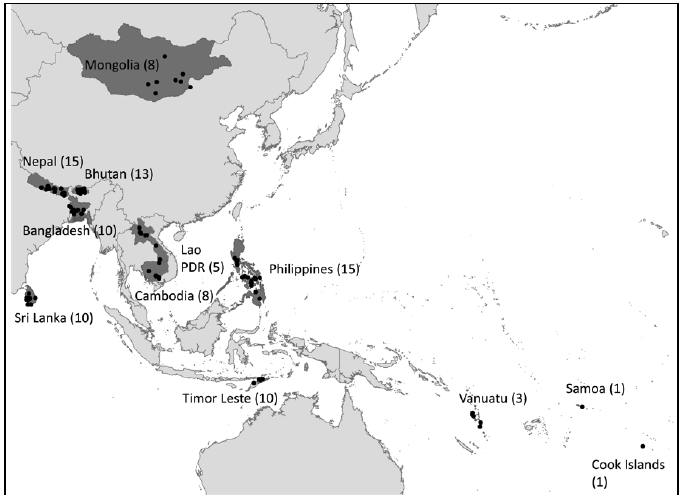
Figure 1. Twelve countries that participated in the WSP impact assessment, with number of participating sites indicated between parentheses. Table 1. Number of sites that participated in the WSP impact assessment by country, type of water system, context (urban/rural), and WSP age.